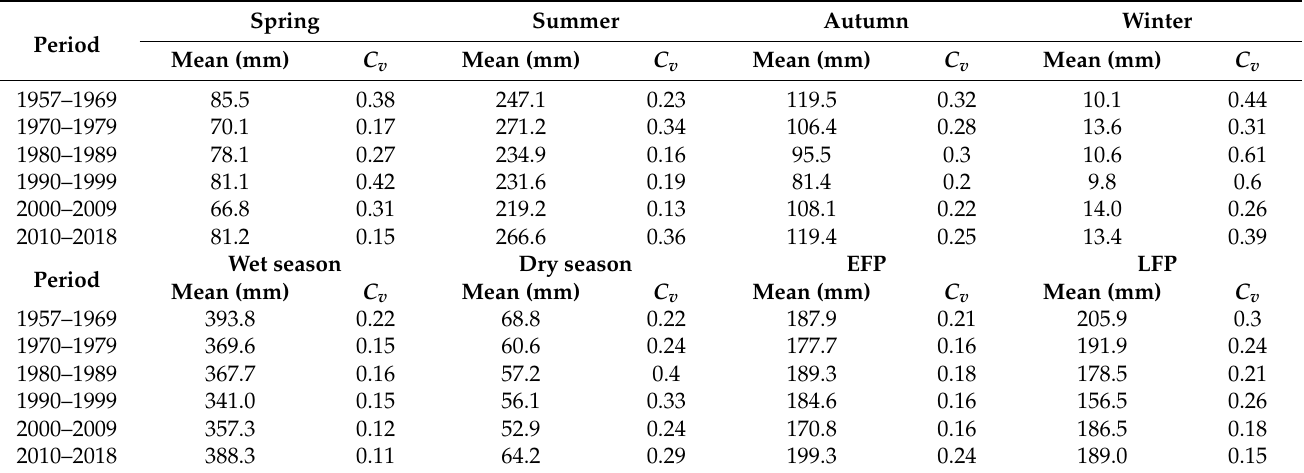
Table 4. The seasonal precipitation (mm) and C v in different time periods over the Loess Plateau.